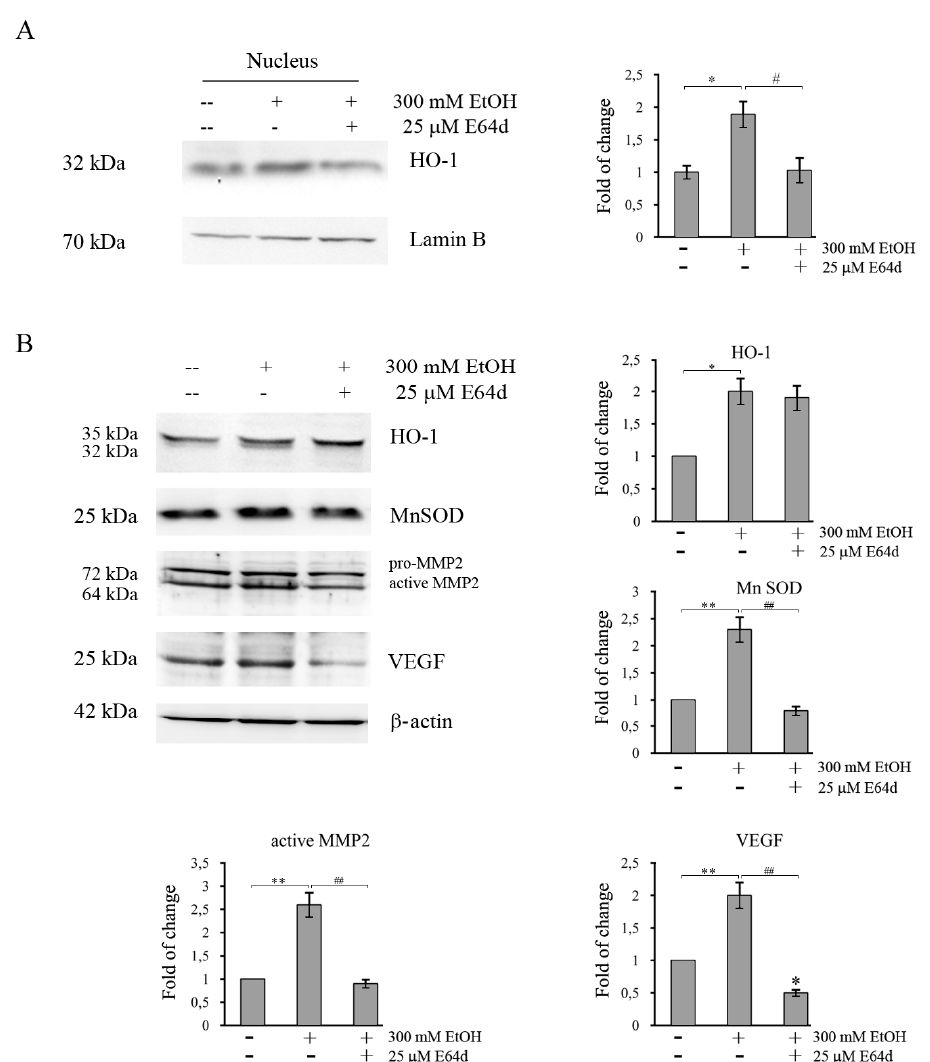
Figure 7. Nrf2-silencing represses the increase in the levels of antioxidant enzymes, MMP2 and VEGF induced by EtOH treatment. ( A and B ) HCT116 cells (1 × 10 5 ) were transiently transfected with a nonspecific siRNA (siControl) or with Nrf2 specific siRNA pool (siNrf2) and, 24 h after transfection, cells were treated with 300 mM EtOH for additional 24 h or 48 h. ( A ) The levels of HO-1, MnSOD, MMP2, and VEGF were analyzed by Western blotting after 24 h of transfection. The successful of Nrf2-silencing was verified by measuring the level of Nrf2 in transfected cells. Quantitative estimations of the protein levels were determined by densitometry measurements of western blotting from three independent experiments after normalization with β -actin (*) p < 0.05 and (**) p < 0.01 compared to the untreated sample. ( # ) p < 0.05, ( ## ) p < 0.01. ( B ) Effects of Nrf2-silencing on the viability of HCT116 cells evaluated after 48 h of EtOH treatment by MTT assay and expressed as the percentage of the viable siControl cells in untreated cultures. Values are the means of three independent experiments ± S.E. ( # ) p < 0.05 between the two groups.